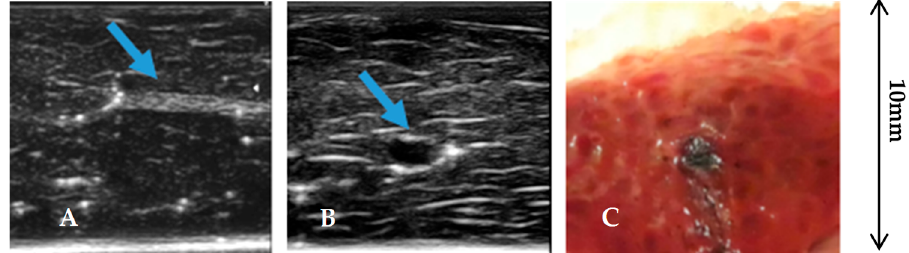
Figure 7. B-scan image of the internal structure of the liver sample ( A ) using a linear array ultrasound transducer SL3116. ( B ) B-scan image of the liver acquired over a 2 mm agar inclusion using the same linear transducer; ( C ) picture of the liver slice obtained dividing the tissue into two pieces in correspondence of the inclusion.